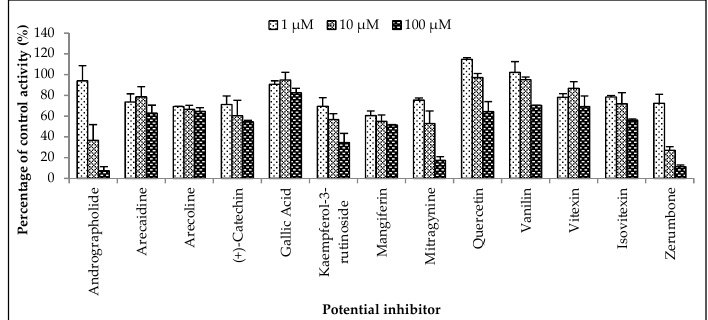
Figure 4. The screening of herbal bioactive constituents on zidovudine (ZDV) glucuronidation in human liver microsomes (HLM). Panels above show concentrations of the inhibitors used. Each bar represents the mean percentage activity relative to control ± standard deviation (SD) for triplicates ( n = 3).